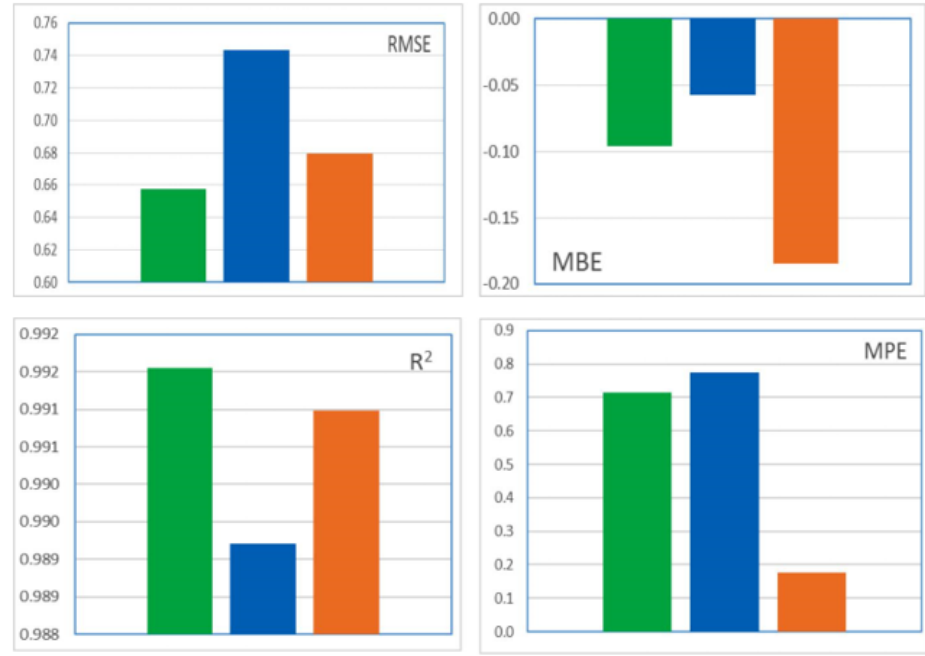
Figure 3. Statistical indicators (RMSE, R 2 , MBE, MPE) graph forthree ANN models at New Borg